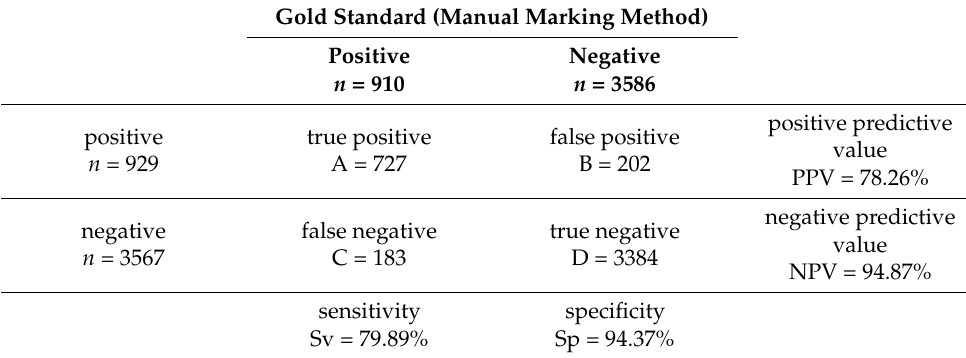
Table 3. Experimental results of the ineffective trigger algorithm. Gold Standard (Manual Marking